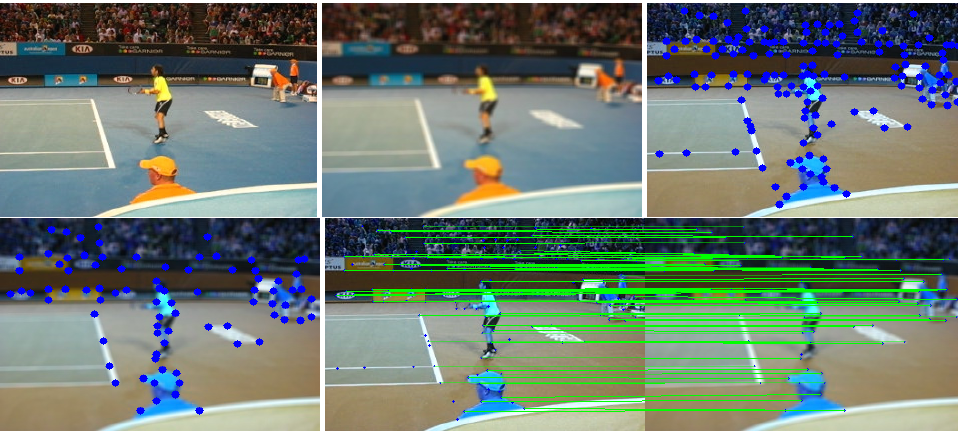
Figure 12. ( Blurring ) Row 1: Left (original image), Middle (attacked images.), Right (resulting point of original image by SuperPoint’s detector). Row 2: Left (resulting point of attacked image by Super- Point’s detector), Right (the green lines show the correct correspondences after blurring attacks).